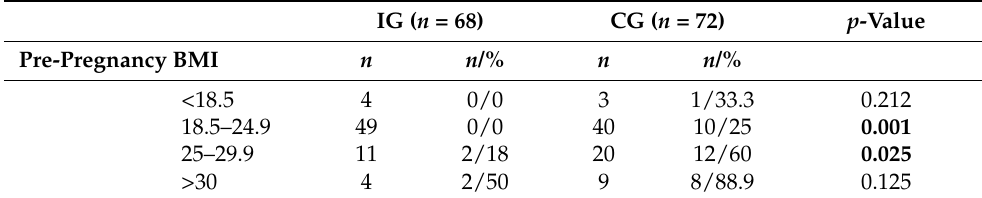
Table 2. Cases of excessive weight gain measured at delivery in both study groups divided by body mass index (BMI): IG—intervention group; CG—control group.